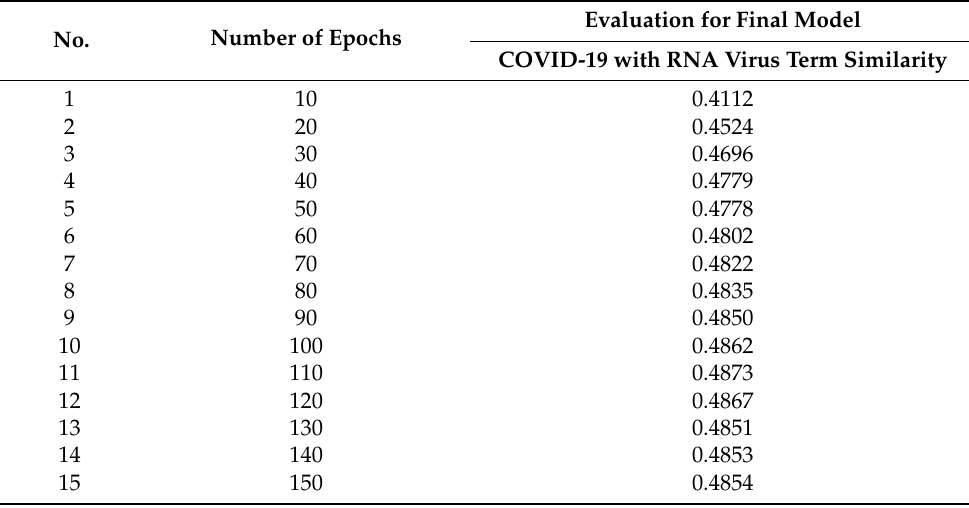
Table 2. Final model evaluation results based on the number of